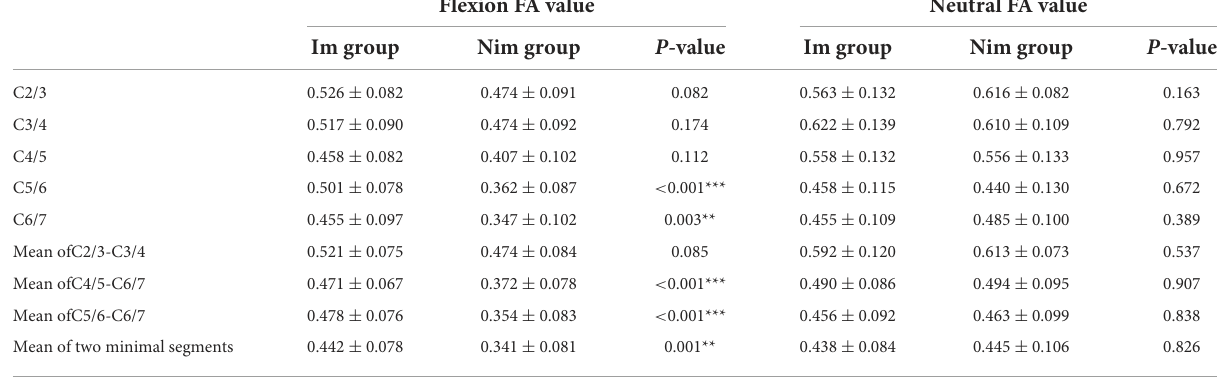
TABLE 4 Comparison of flexion and neutral FA values between the two groups of